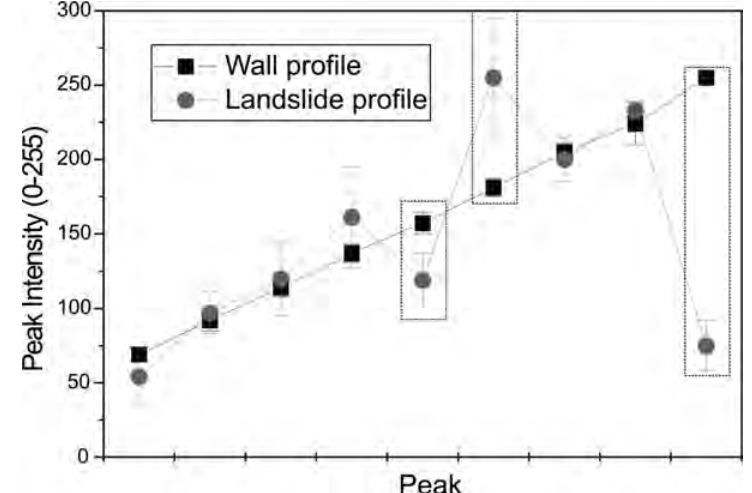
Fig. 6. Peaks distribution comparisons: red and black points are referred to landslide and volcanic wall respec- tively. Yellow boxes evidence the discrepancies.